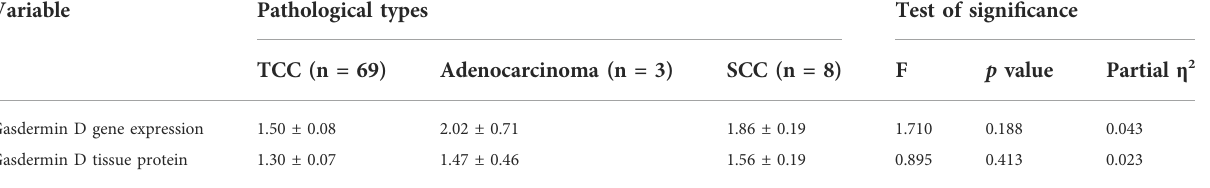
TABLE 3 Gasdermin D gene (by real-time PCR) and protein expression (by western blotting) in the bladder cancer tissue samples from the different pathological types: